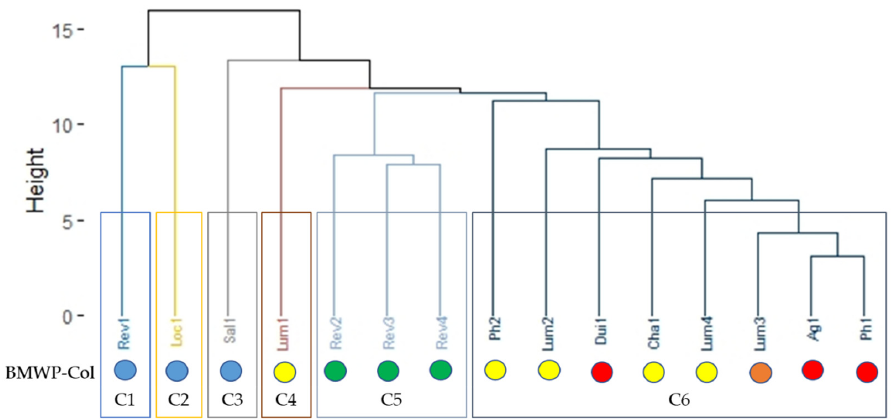
Figure 6. Community-based clustering of locations. Axes represent the distance among sampling sites based on abundances (discrete values). The BMWP-Col class for each site is shown in coloured circles, where blue = good, green = moderate, yellow = poor, orange = bad, and red = very bad quality.